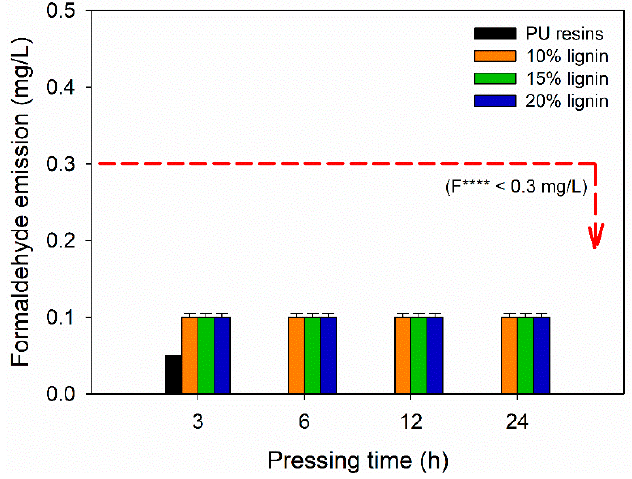
Figure 9. Formaldehyde emission of plywood bonded with PVOH–lignin–hexamine-based adhesives at different lignin contents and pressing times.